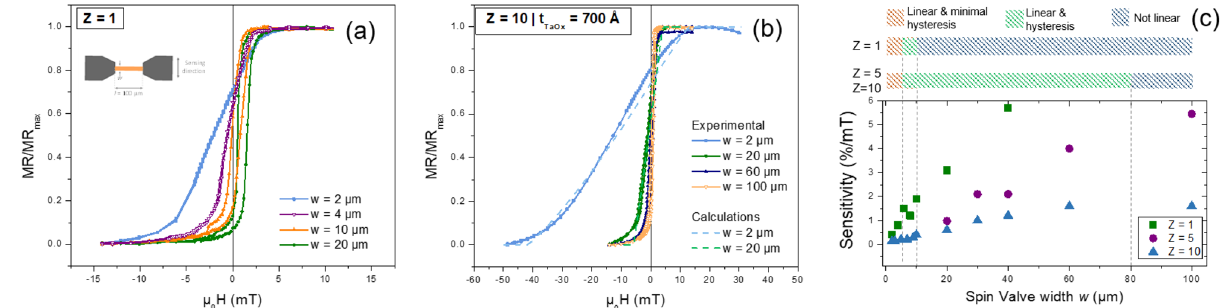
Figure 4. Normalized transfer curve of spin-valve sensor for ( a ) Z = 1 and ( b ) Z = 10 by varying the width from 2 to 100 µ m. For Z = 10 is also shown calculated curves from the developed macrospin model for w = 2 µ m and 20 µ m. ( c ) Sensitivity as a function of the sensor width obtained at the most sensitive point of the curve. Three regions are defined to describe the sensor behavior accounting for its hysteresis and linear output.